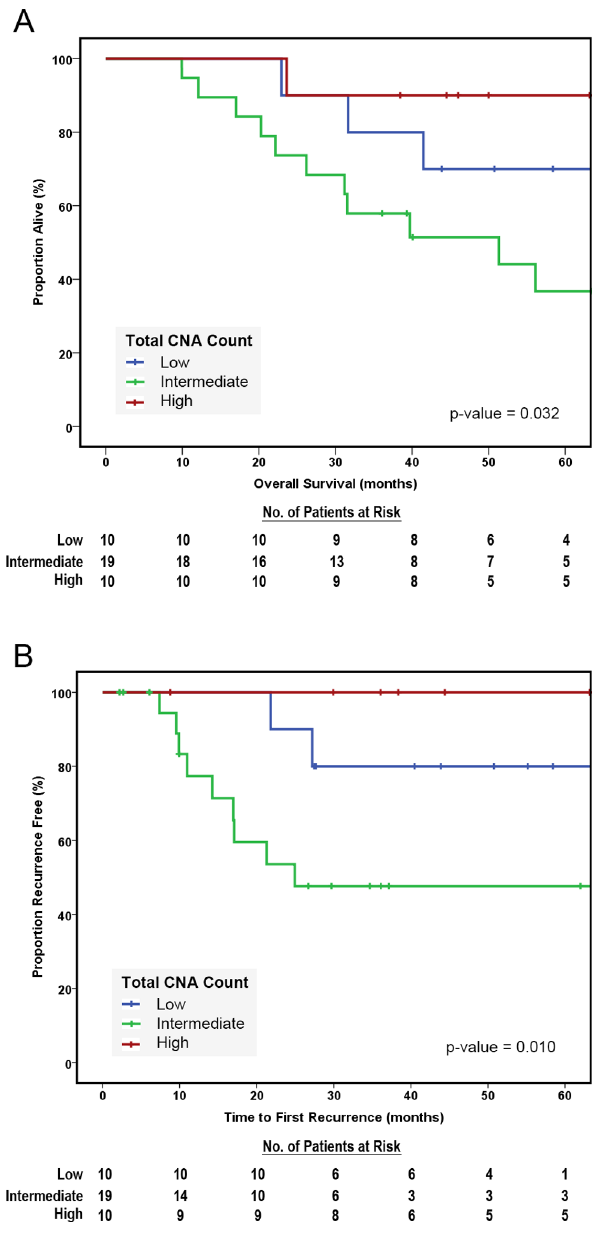
Figure 4. Overall Survival and Time to First Recurrence for Superficial EAC Stratified by Total CNA Count. (A) Patients with intermediate total CNA counts had significantly worse overall survival than patients with low or high total CNA counts (log rank p- value=0.032). (B) Similarly, patients with intermediate total CNA counts had significantly shorter time to first recurrence than those with low or high total CNA counts (log rank p-value=0.010). doi:10.1371/journal.pone.0079079.g004 angiolymphatic invasion, tumor size, tumor grade, number of lymph nodes resected, Table 3). Multivariate analysis was performed to adjust for confounding prognostic variables. On univariate analysis, intermediate total CNV count was an adverse prognostic factor (HR 3.7, 95% CI 1.3–10.7) and remained a 3.4- fold increased hazard of death (95% CI 1.1–10.4) after adjusting for other borderline or significant (p-value , 0.2) predictors of survival (N stage, angiolymphatic invasion and tumor size).